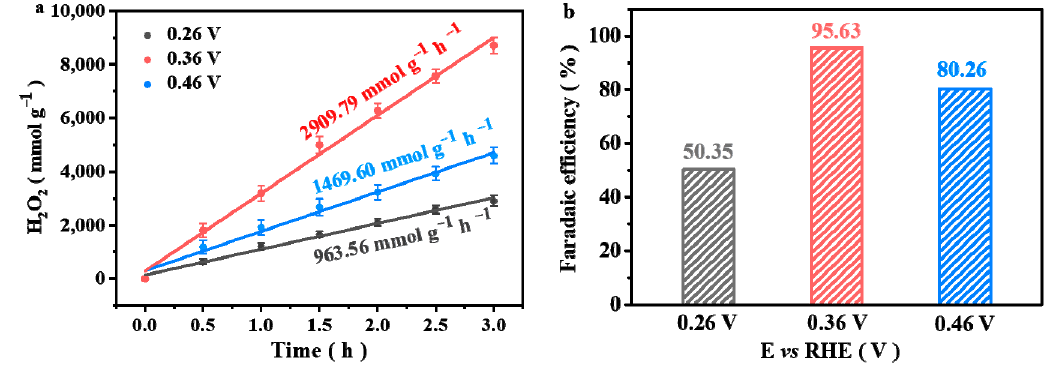
Figure 3. ( a ) H 2 O 2 production rate; ( b ) the corresponding faradaic efficiency (FE%).